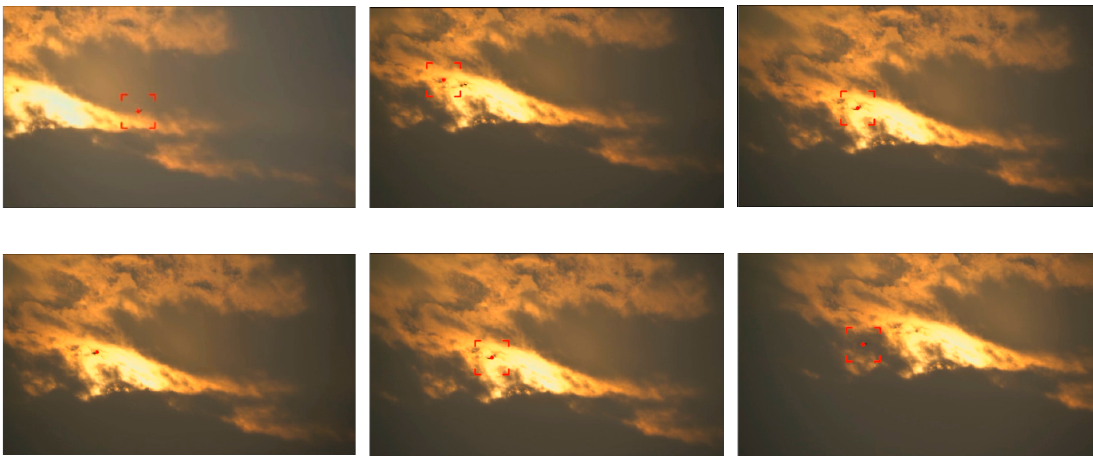
Figure 14. Results of the tracing test on sunny days (drone flight altitude is 105 m).